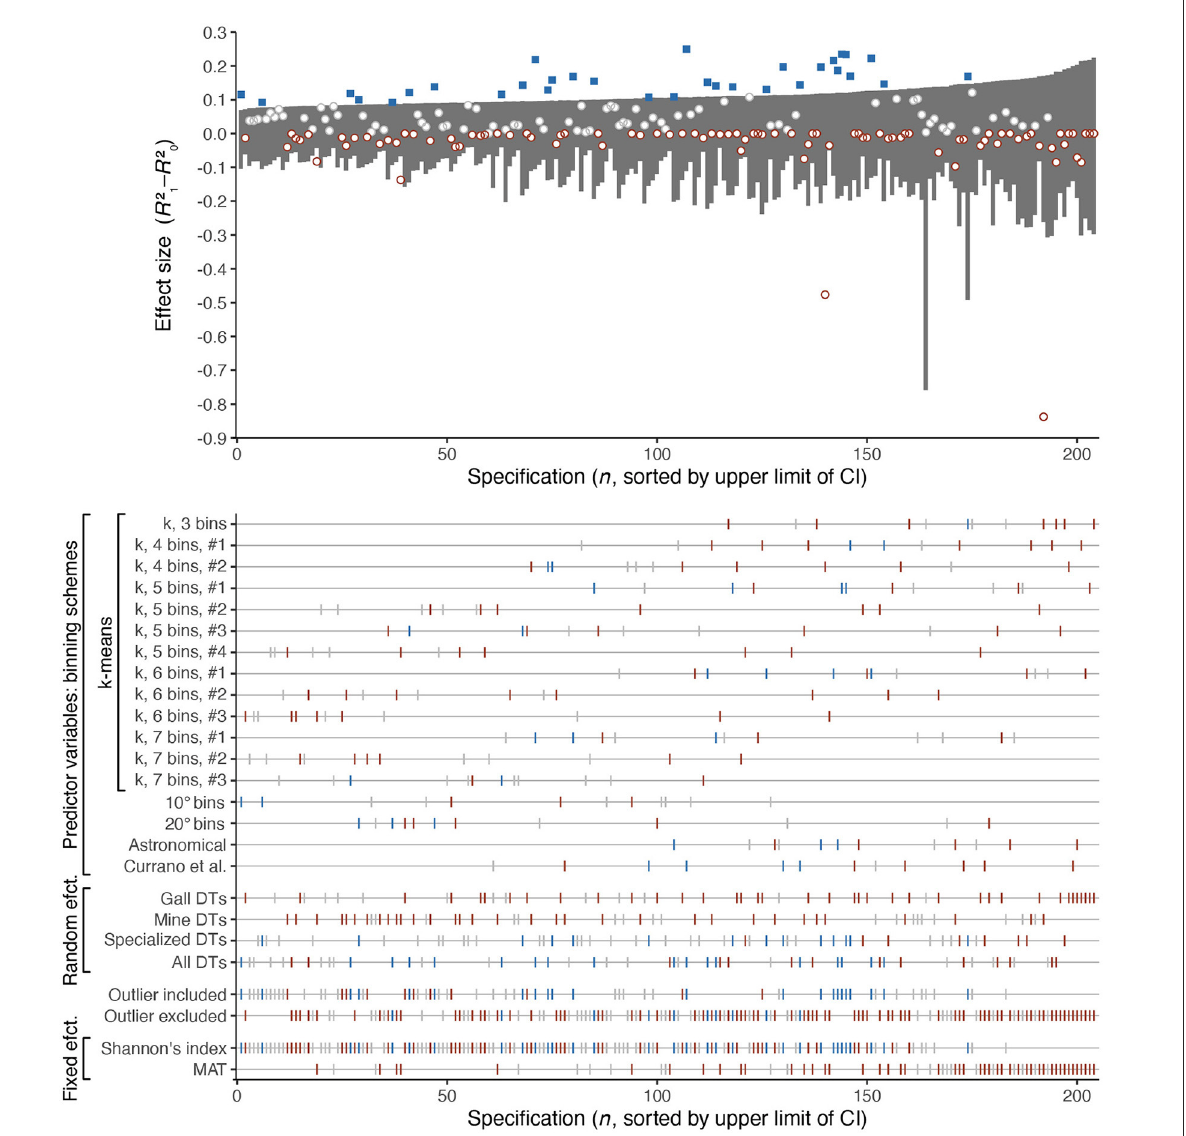
FIGURE10 Specification curve analysis of the ostensible heightened richness of insect damage types at mid-southern latitudes. The dark gray rectangles in the upper panel denote the 95% confidence interval for each specification. Blue squares denote specifications for which the effect size is greater than predicted by the 95% confidence interval. Red circles denote specifications for which the effect size is less than zero. Damage type (DT) richness was estimated after rarefying each assemblage to 300 leaves. The method for calculating effect size is explained in the